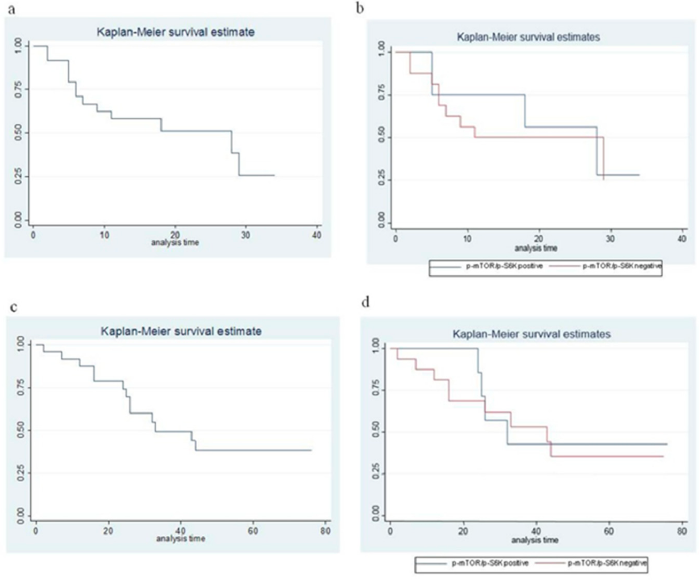
Figure 2. Progression-free and overall survival in the whole series (a,c) and according to p-mTOR/p-S6K expression (b,d).